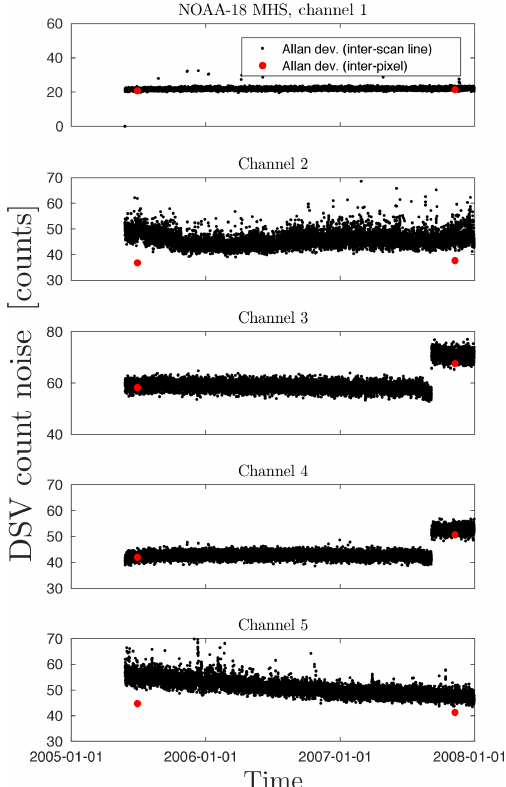
Figure 3. The DSV count noise per channel for the years 2005 to 2008 for MHS on NOAA-18. The red dots indicate the noise in DSV counts calculated with the inter-pixel method. For comparison with the inter-scan-line method, we applied this method exemplarily only for the two orbits 505 of 2005 and 4500 of 2007, for which we investigated the spectrum as well (see Fig.